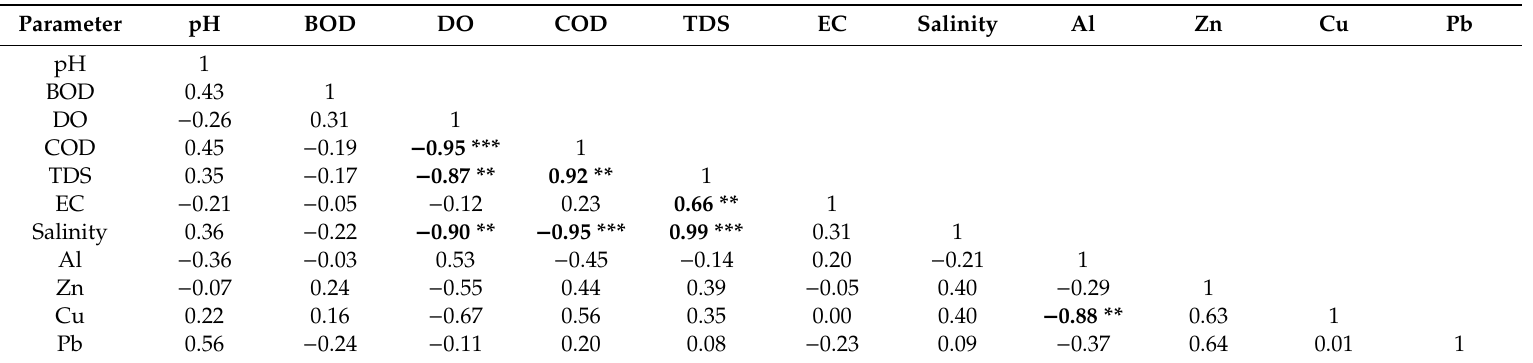
Table 4. Two-tailed Pearson’s correlation coe ffi cients for the physicochemical parameters and toxic heavy contents in the Leeuwkuil WWTP influent and e ffl uent §